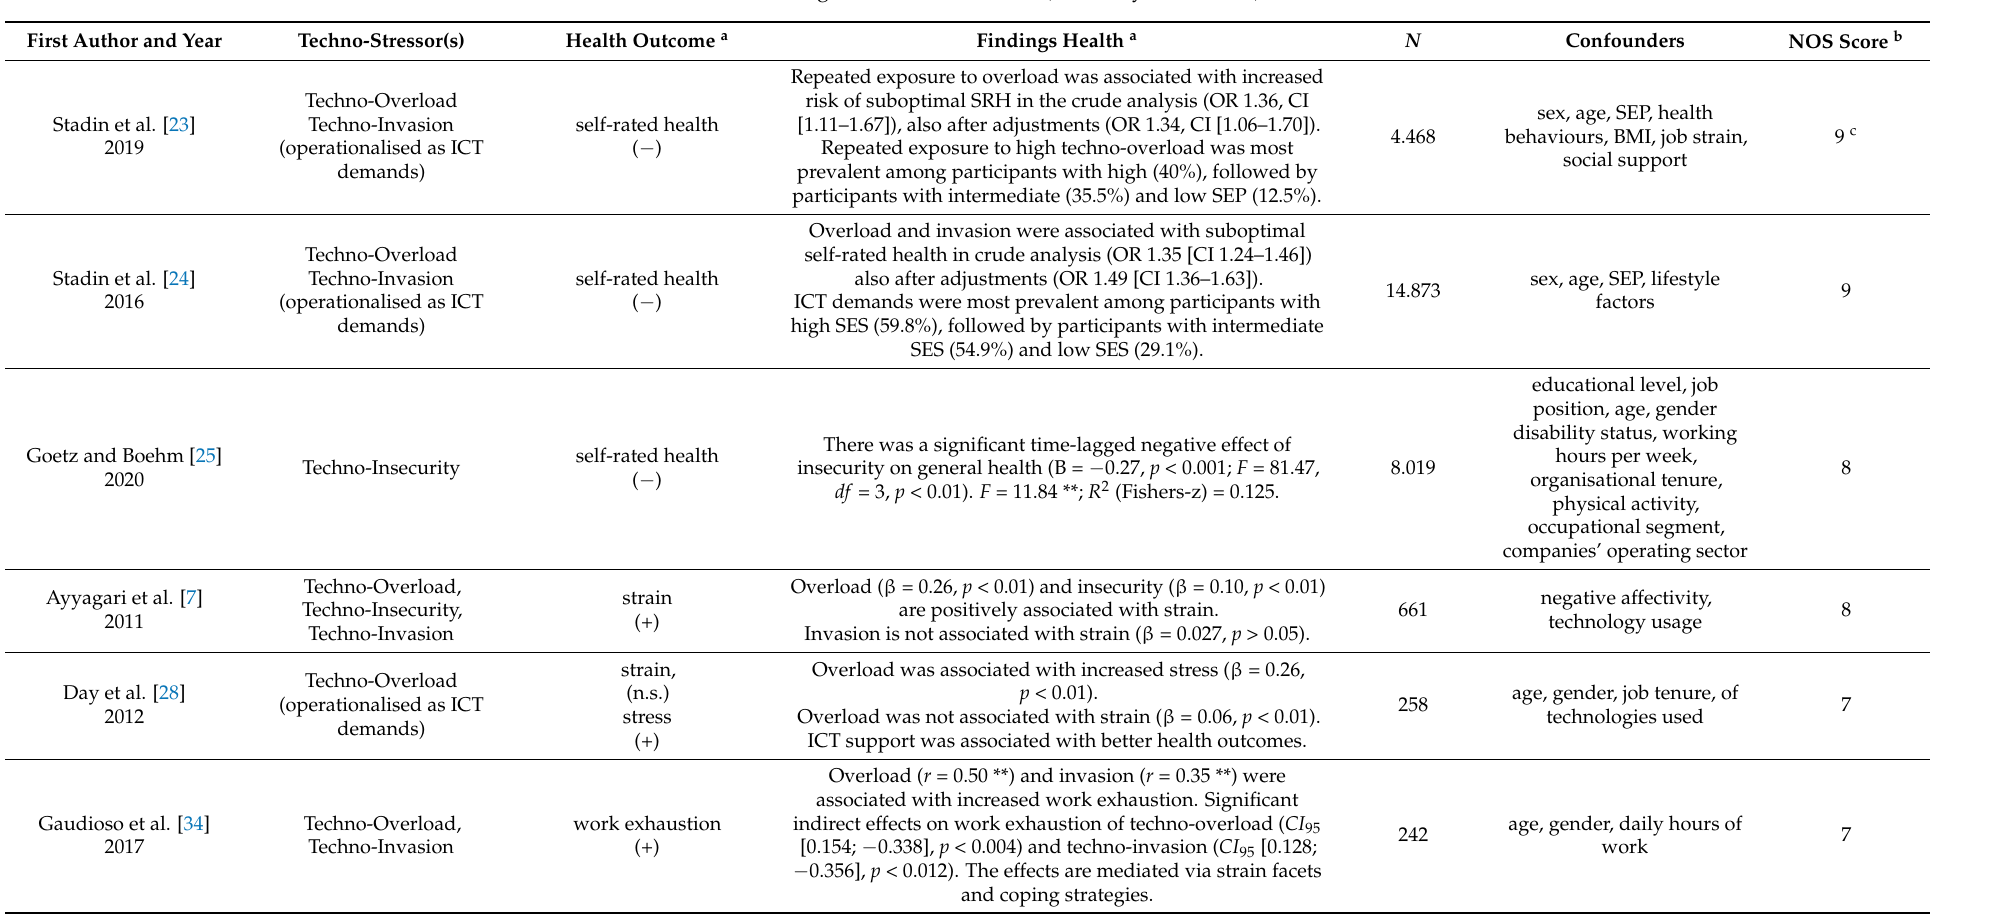
Table 1. Findings on health outcomes (sorted by NOS